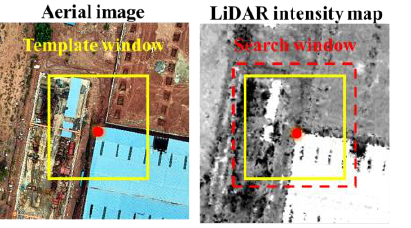
Figure 8. Similarity